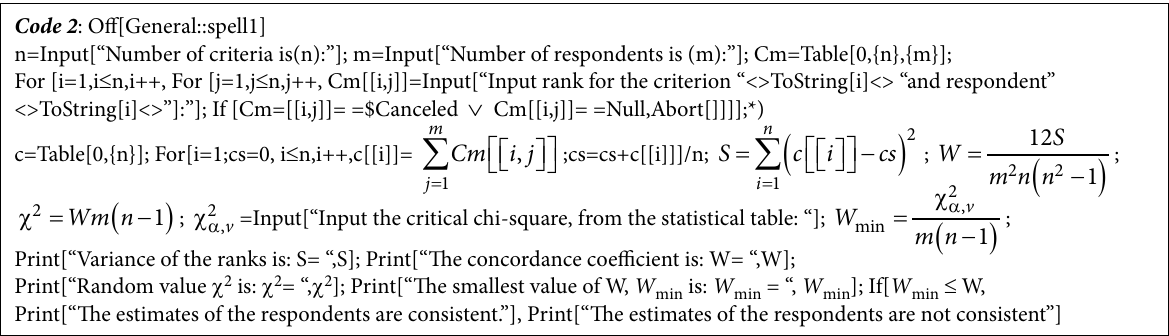
Table 11. Code 2: estimating the level of consistency of respondents’